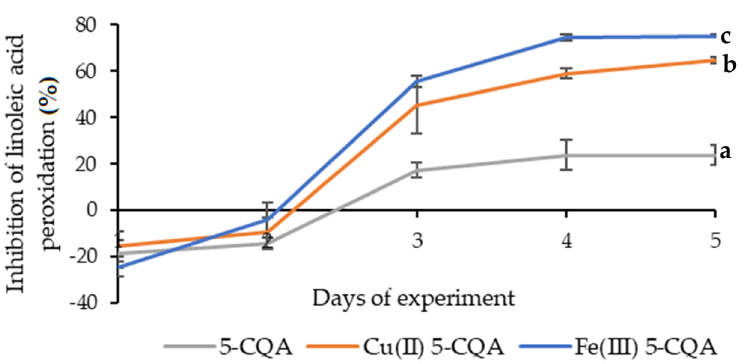
Figure 11. Linoleic acid peroxidation inhibition assay of 5-CQA, Cu(II) 5-CQA, and Fe(III) 5-CQA (0.001 M). Mean values from three independent experiments ± SDs are shown. The same letter near the means indicates no significant difference (Tukey’s test, p <